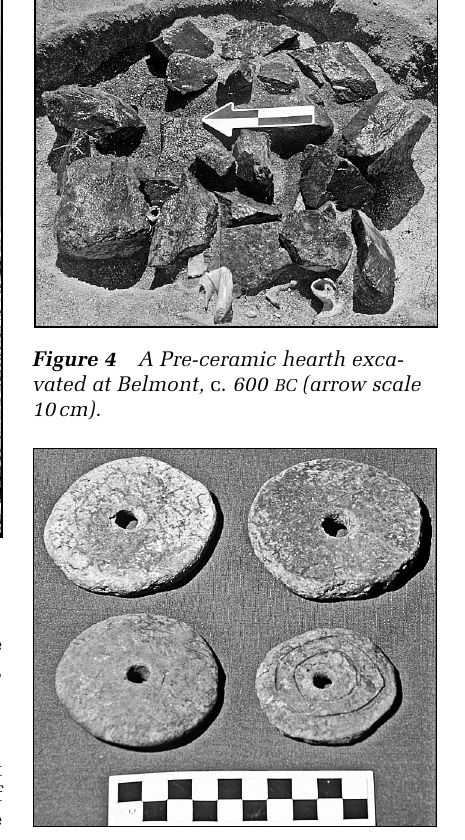
Figure 5 Ceramic Age spindle whorls used in the processing of cotton, c. AD 1000 (scale-bar intervals